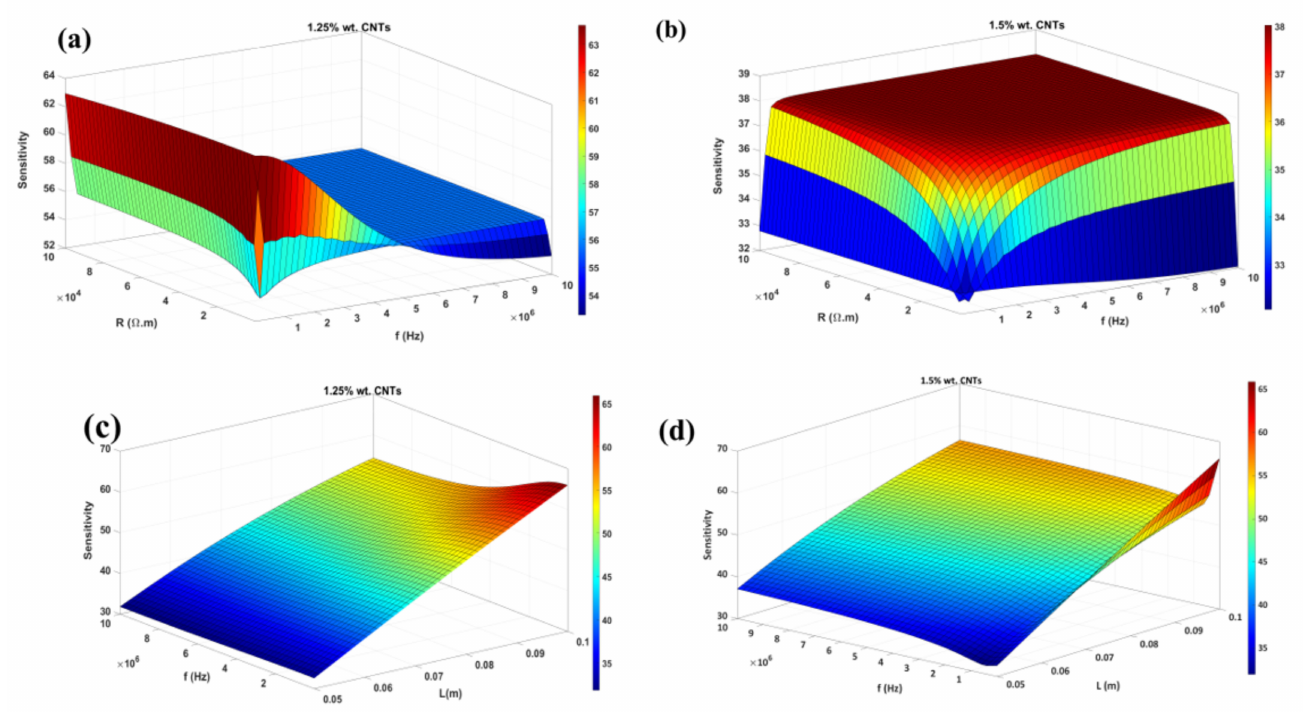
Figure 11. 3D effect of different input parameters on shape of objective function (sensitivity): ( a ) frequency and resistivity for 1.25% wt. CNTs ( b ) frequency and resistivity for 1.5% wt. CNTs ( c ) frequency and length for 1.25% wt. CNTs ( d ) frequency and length for 1.25% wt.